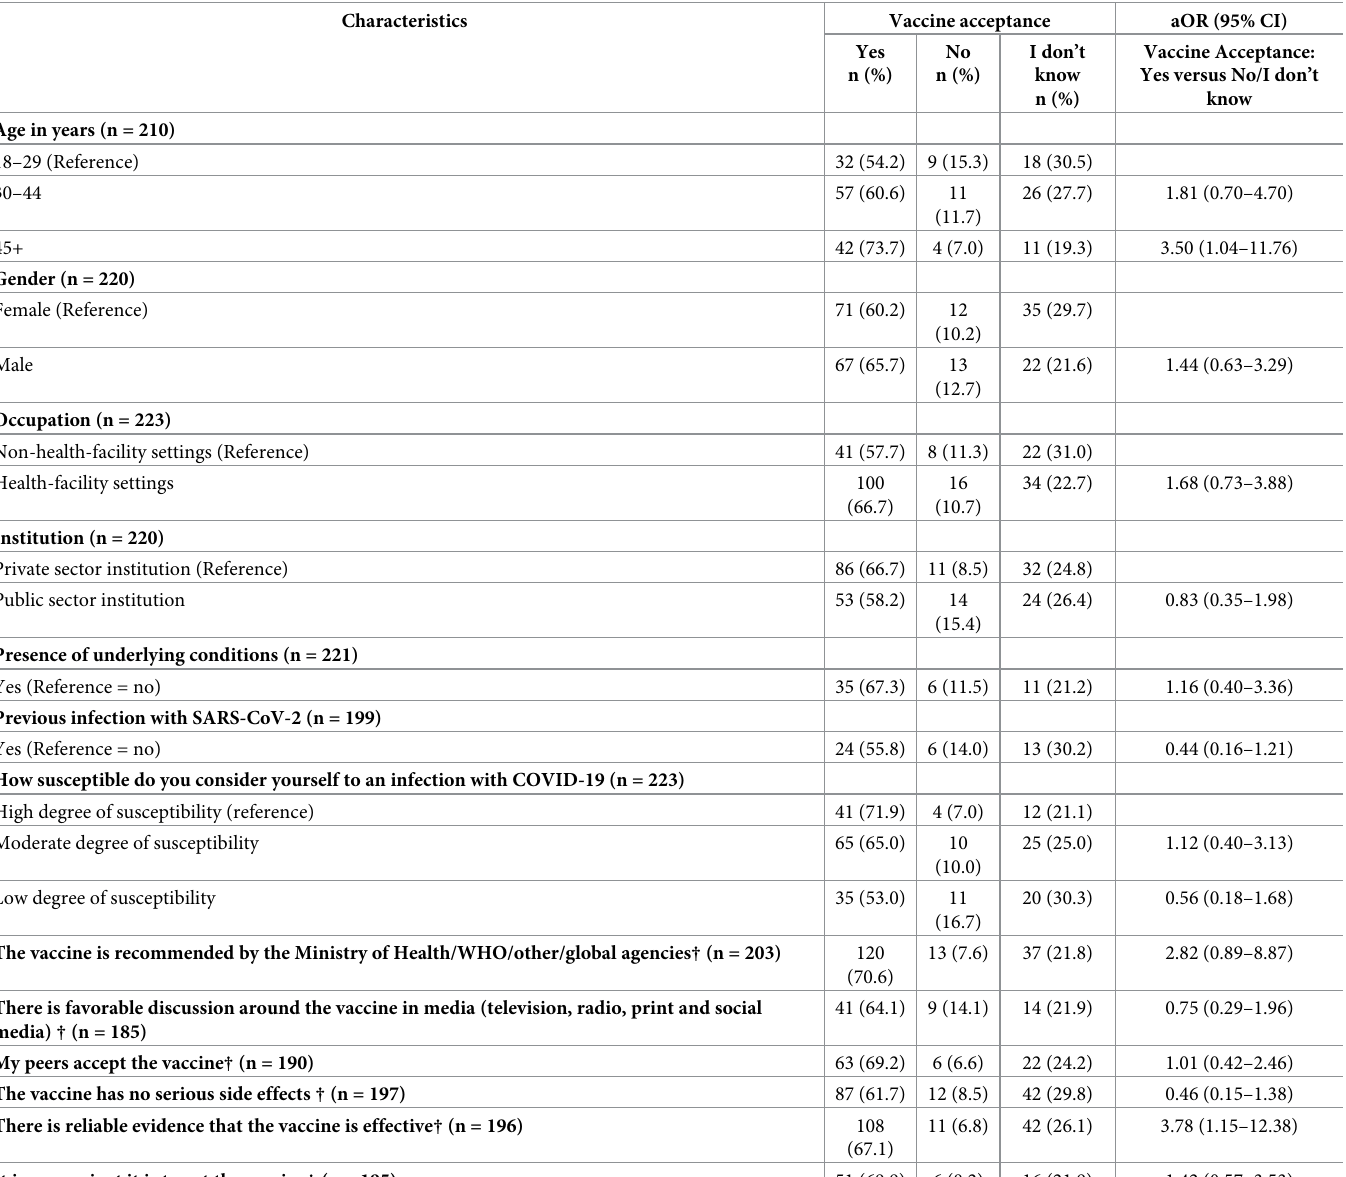
Table 2. Factors influencing the decision to accept a COVID-19 vaccine currently approved by the government among respondents who had not yet received a vac- cine at the time of survey administration (n =